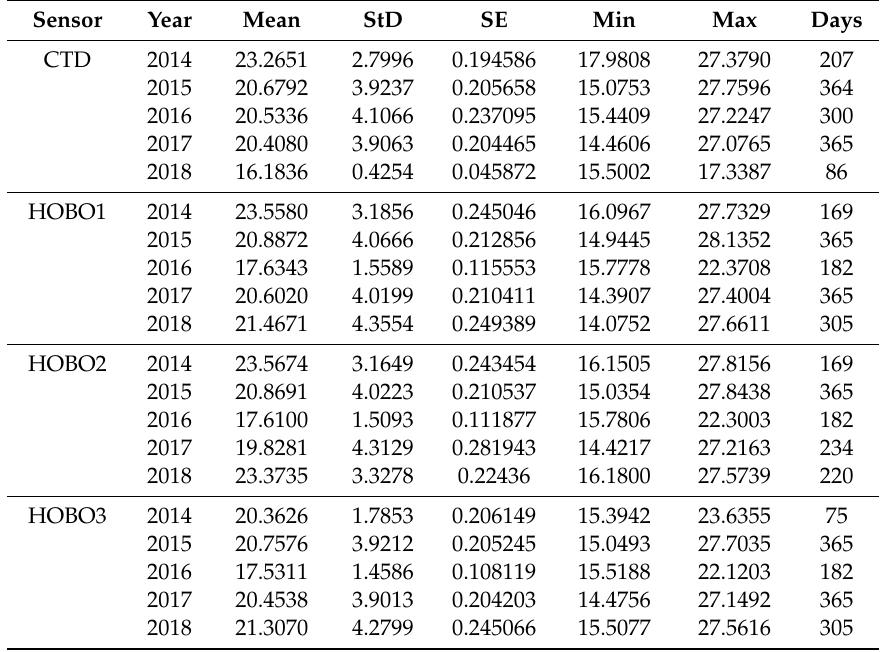
Table A2. Statistical data extracted from daily averaged values of the deployed instruments in the Underwater Biotechnological Park of Crete, and the corresponding days of measurement for every year. Interannual variations occur due to di ff erent periods of deployment from year to year (see Table A1). The mean value of daily averaged data, the standard deviation, the standard error, the minimum, and maximum values for each data series are